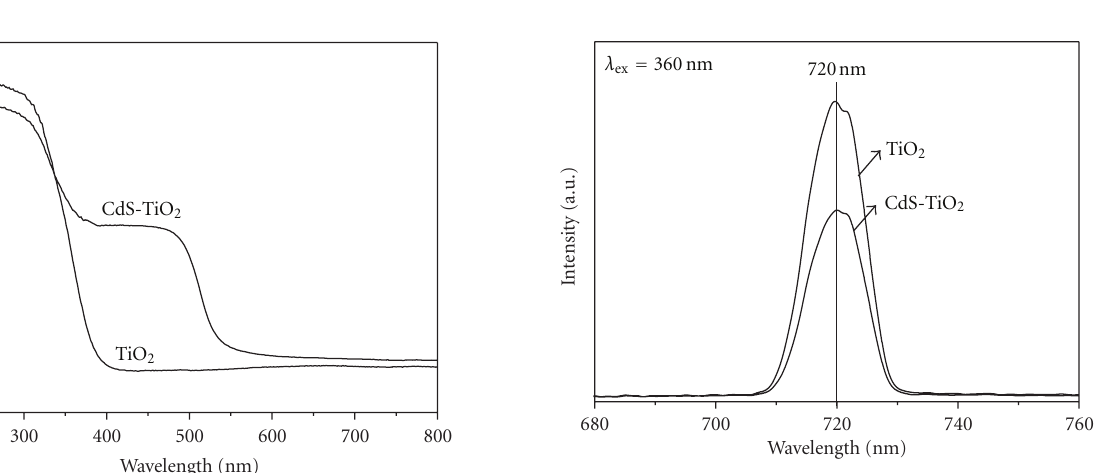
Figure 3: UV-vis DRS spectra of CdS-TiO 2 Band TiO 2 samples.